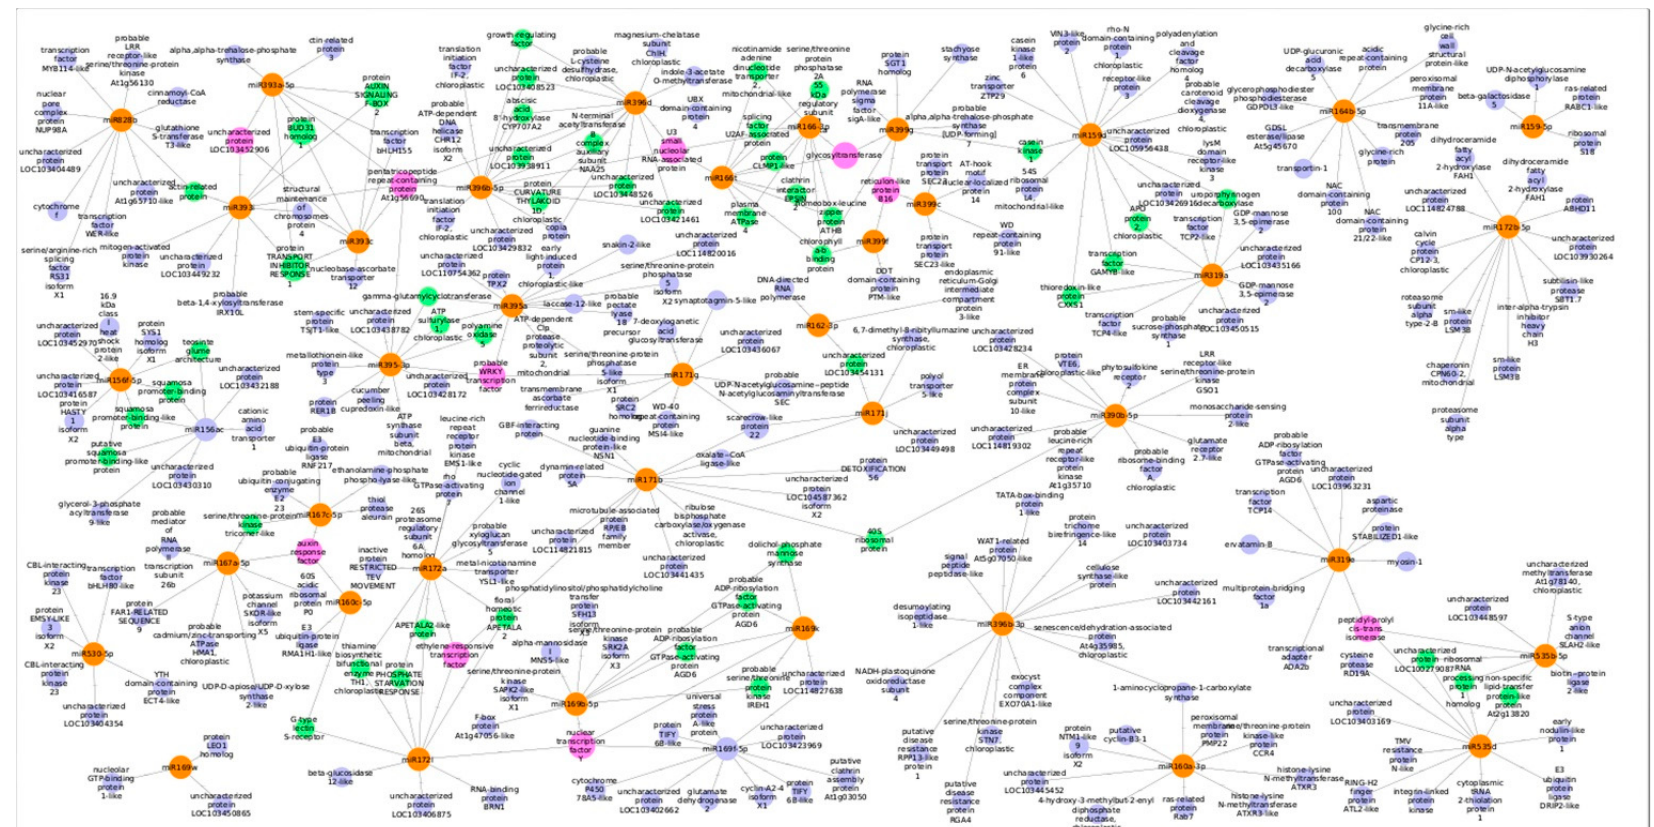
Figure 9. Minimum free energy (MFE) based network interaction of potential guava miRNAs and their corresponding targets. Different guava miRNAs and their targets are marked with orange and blue circles, respectively. Targets marked with the green circle are shared by two miRNAs, while targets marked with the pink circle are shared by 3 or more miRNAs.